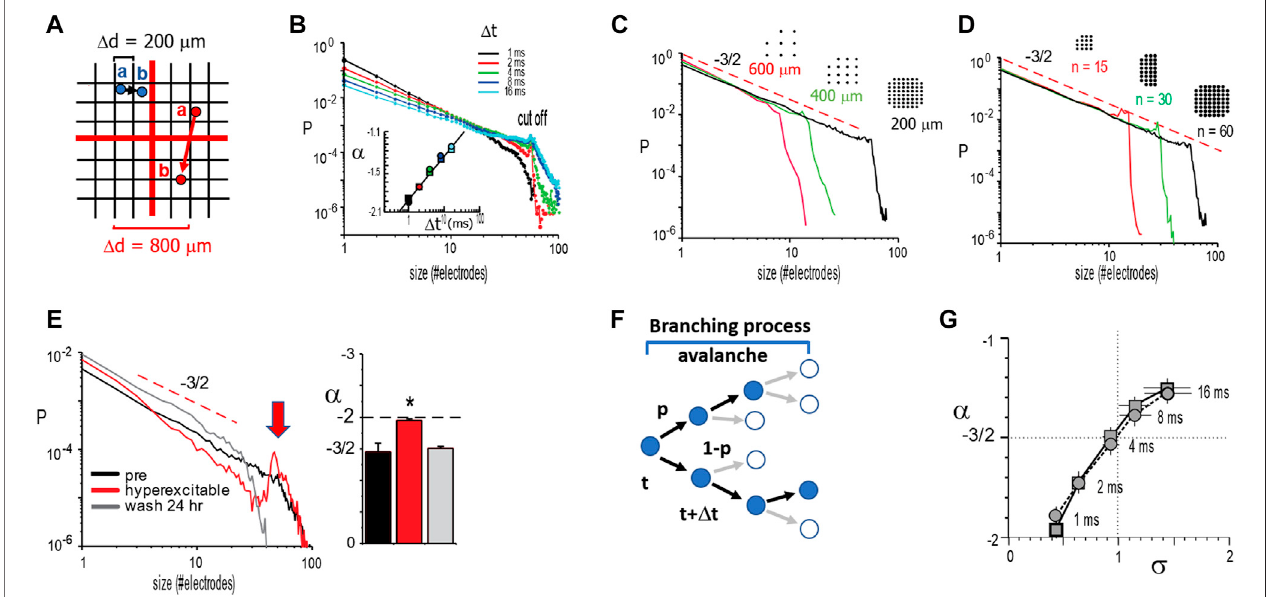
FIGURE 5 | Temporal and spatial scaling links size distribution slope − 3/2 to a critical branching parameter for neuronal avalanches. (A) When identifying spatial propagation of activity over time (a → b; blue and red circles), the distances between neighboring electrodes on a multielectrode array introduce a discrete spatial scale Δ d. For different spatial scales (grids: black : 200 μ m; red : 800 µm) and a fi nite propagation velocity < v > , the time Δ t to wait in order to identify propagation toward an electrode is approximately Δ t (cid:3) < v > * Δ d. (B) In organotypic cortex cultures, at fi xed Δ d (cid:2) 200 μ m, an increase in Δ t results in a power law of avalanche size with a shallower exponent α due topreferential concatenation ofavalanches (avalanche size based on the number ofactive electrodes). Note the absence ofany changein the power law form itself. Inset : average change in α with Δ t over all cultures and size based on electrodes ( circles ) or nLFP amplitudes ( squares ). (C) A change in Δ d by accordingly omitting electrode rows and columns ( insets ) maintains the size distribution slope of − 3/2 ( broken line ) if correspondingly increasing Δ t to Δ t (cid:3) < v > * Δ d. (D) Finite-size scaling using compact subarrays ( insets ) only affects the power law cutoff, but not power law slope α . Broken line : slope of − 3/2. (E) Reducing inhibition pharmacologically using picrotoxin (PTX) leads to hyperexcitable neuronal cultures, resulting in a “ supercritical ” phenotype with an initial, steep slope close to ∼ − 2 and a preference for large, i.e., system-wide propagated, population events ( red arrow ). Right : quanti fi cation of change in α from − 3/2 → − 2 when reducing inhibition. (F) The unfoldingofanavalancheinanetworkviewedasabranchingprocess.Inthissketch,activityataninitialsiteattime t caninduceactivityatanothersitewithprobability p or fails to induce activity at a new site with probability 1 – p. Each site exhibits a potential branching to two new sites. (G) Experimental demonstration that avalanche dynamicscrossesthecriticalpoint( σ , α ) (cid:2) (1, − 3/2)predictedforacriticalbranchingprocesswithchangein Δ tat fi xed Δ d.Avalanchesizede fi nition( squares,circles